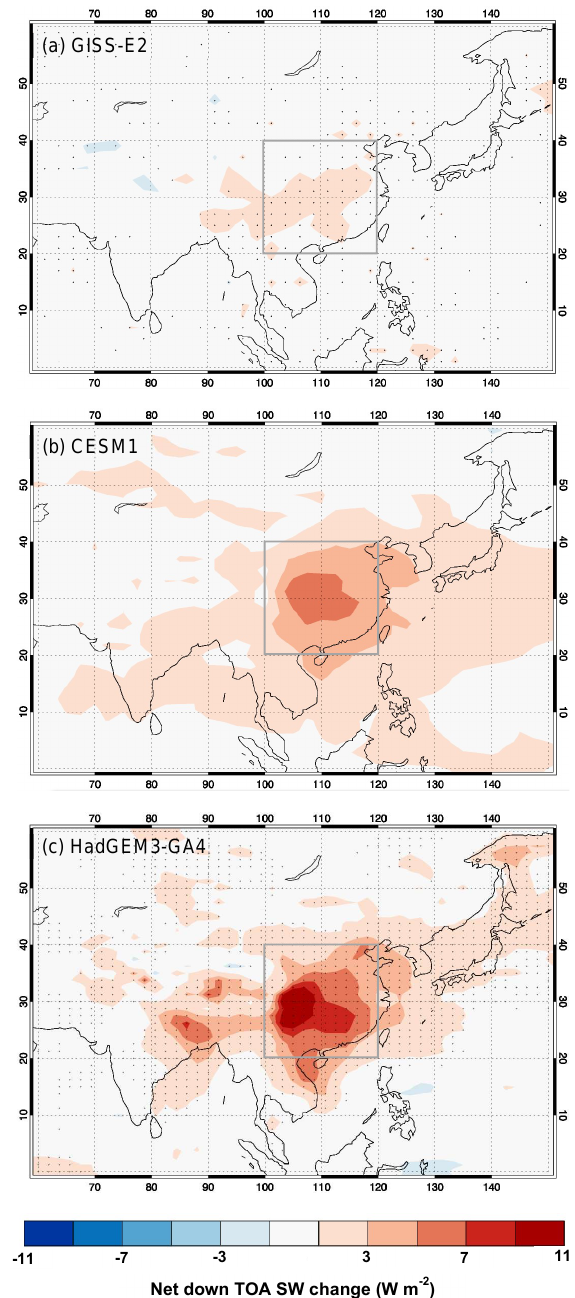
Figure 1. Change in net downward TOA SW flux due to re- moval of anthropogenic SO 2 emissions over China for (a) GISS-E2, (b) CESM1, and (c) HadGEM3-GA4. Differences are calculated as the 150-year annual mean of the perturbation simulation minus the 150-year annual mean of the control simulation. Plots focus on the Asian region as changes outside this domain were found to be minimal. Stippling for GISS-E2 and HadGEM3-GA4 indicates that the change in that grid box exceeded 2 standard deviations. Signif- icance was not evaluated for CESM1 as multiple 150-year control runs were not available to assess internal variability for this model. The grey box denotes the E. China (100–120 ◦ E, 20–40 ◦ N) region which is used in Table 2 and throughout the